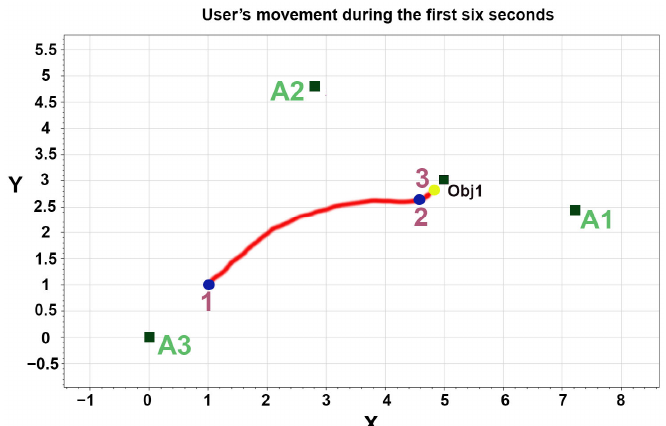
Table 3. Experimental condition in experiment B. We evaluated the indoor positioning system’s accuracy in estimating users’ positioning data and the distance from a specific fixed object.